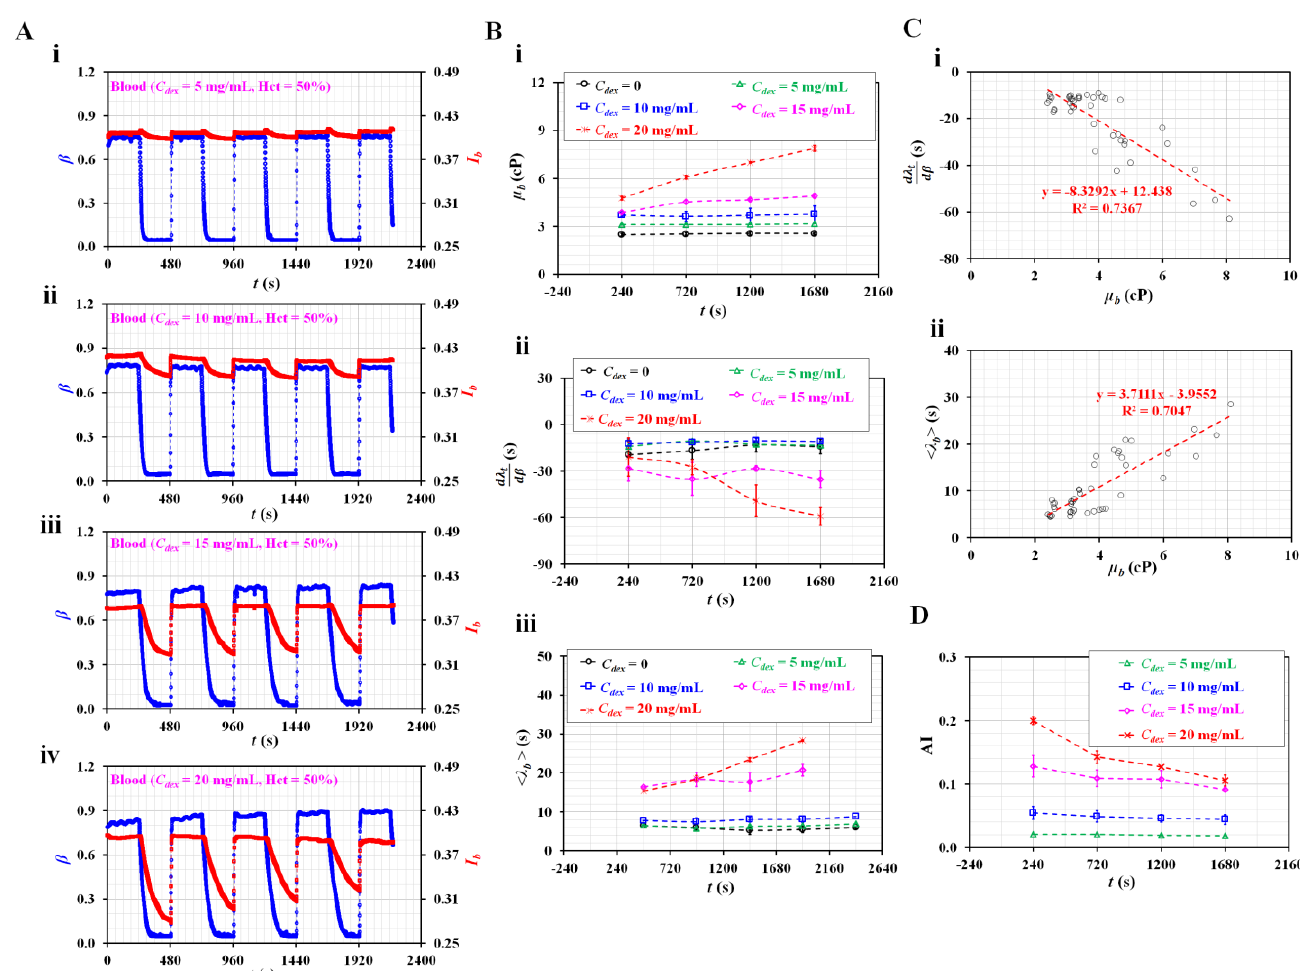
Figure 7. Quantification of haemorheological properties of RBC aggregation-induced bloods. ( A ) Temporal variations in interface ( β ) and image intensity of blood ( I b ) with respect to concentration of dextran ( C dex ) (( i ) C dex = 5 mg/mL, ( ii ) C dex = 10 mg/mL, ( iii ) C dex = 15 mg/mL, and ( iv ) C dex = 20 mg/mL). ( B ) Variations in the haemorheological properties with respect to C dex . ( i ) Temporal varia- tions in µ b with respect to C dex . ( ii ) Temporal variations in 𝑑𝜆 𝑡 with respect to C dex . ( iii ) Temporal 𝑑𝛽